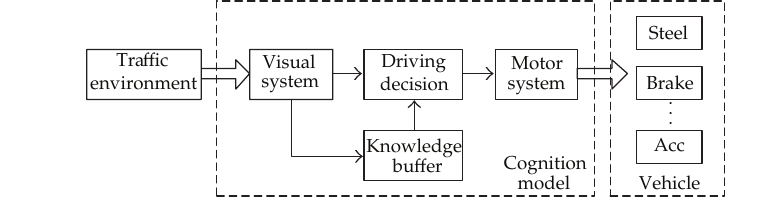
Figure 2: The simplified cognition model.